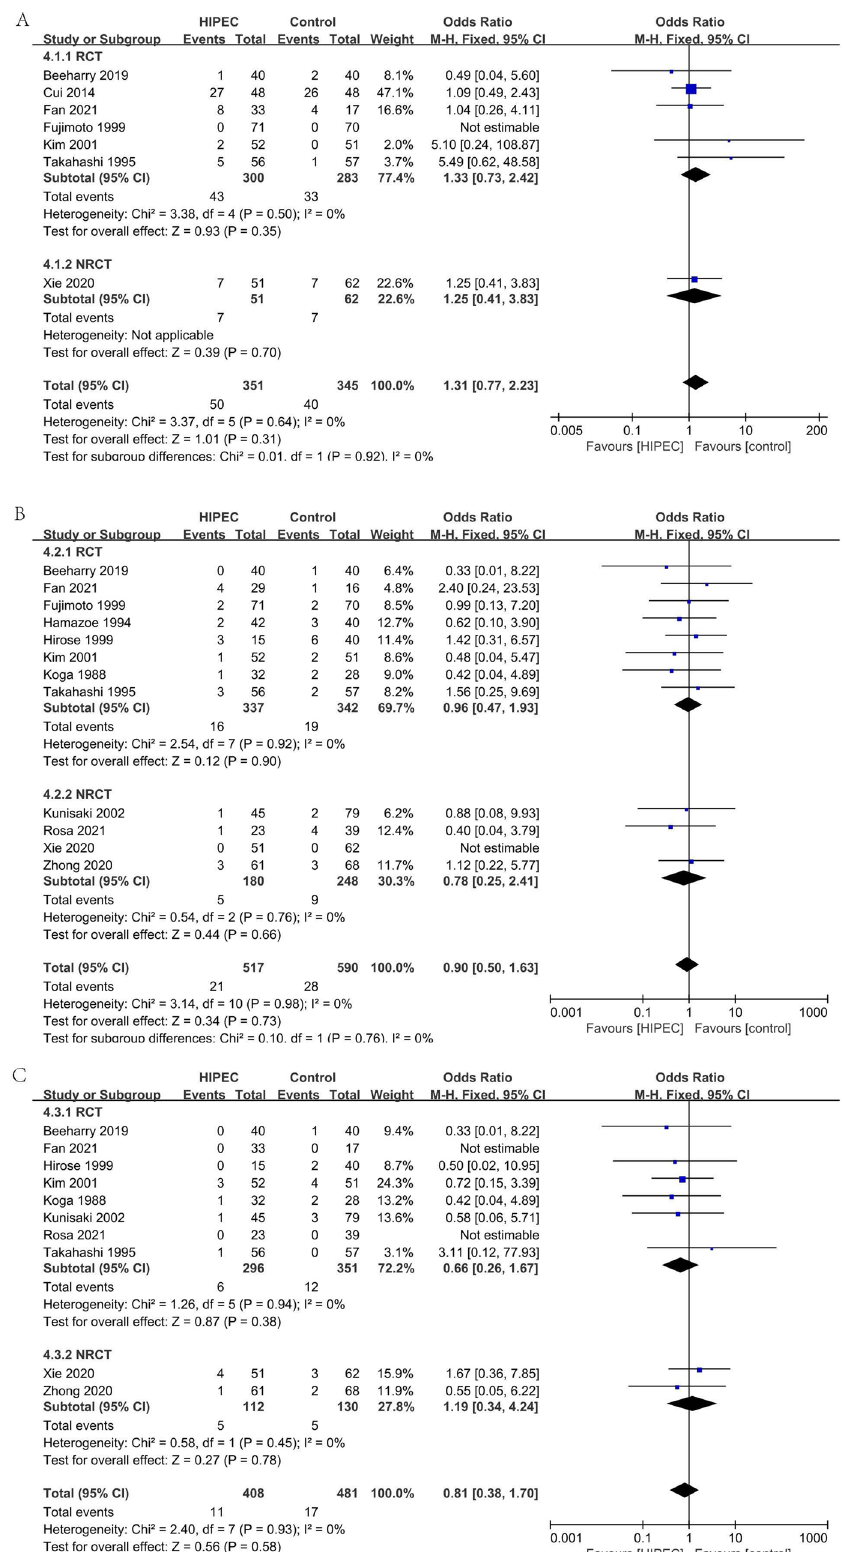
Figure 8. Complication: myelosuppression ( A ), Complication: leakage ( B ), Complication: intestinal obstruction ( C